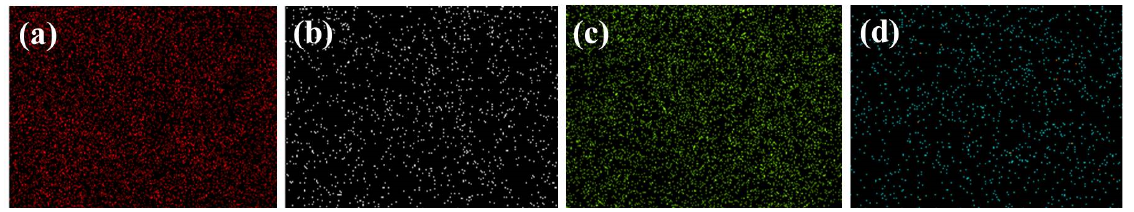
Figure 8. The EDS elemental mapping of ( a ) Zr, ( b ) Mg, ( c ) O, and ( d ) N distribution of the APTMS- modified Zr–Mg mixed oxide aerogels with Zr/Mg molar ratio of 7/3.